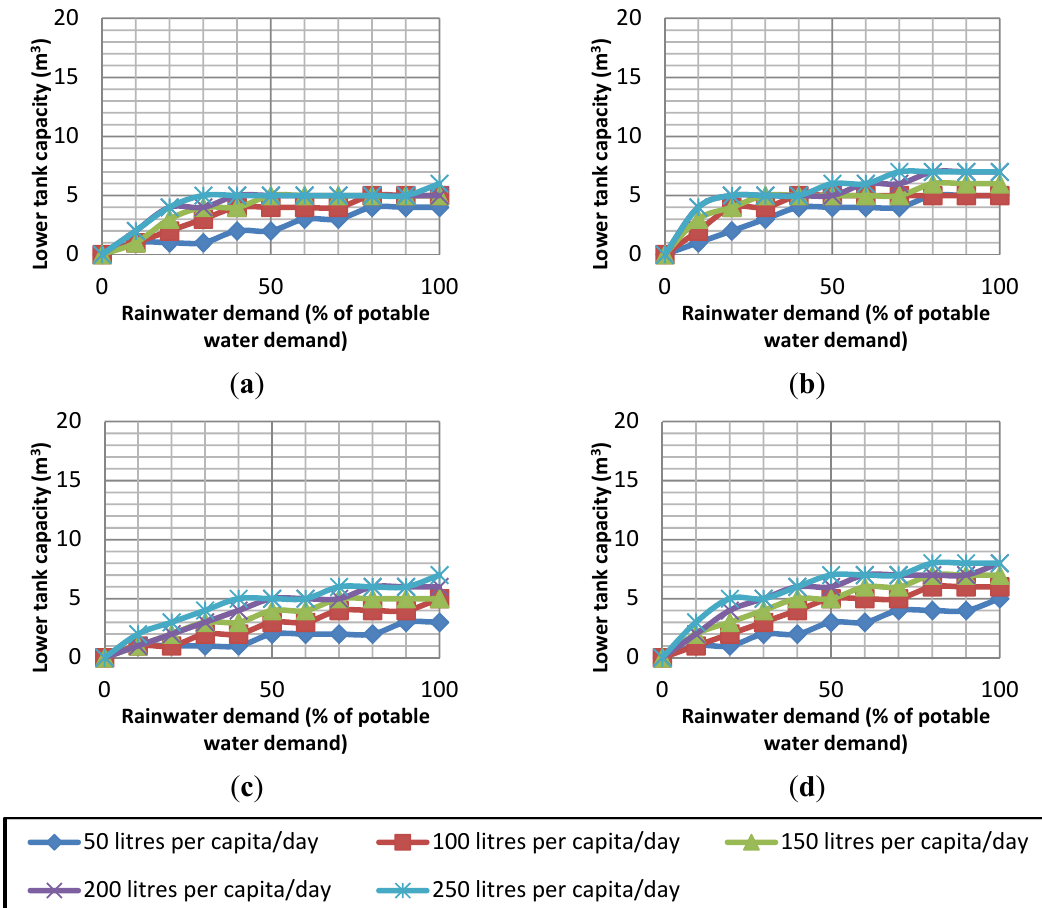
Figure 15. Rainwater tank capacity as a function of rainwater demand, catchment surface area, and number of people per house in Santarém, Brazil. ( a ) 100 m 2 and two people; ( b ) 100 m 2 and four people; ( c ) 400 m 2 and two people; ( d ) 400 m 2 and four people.